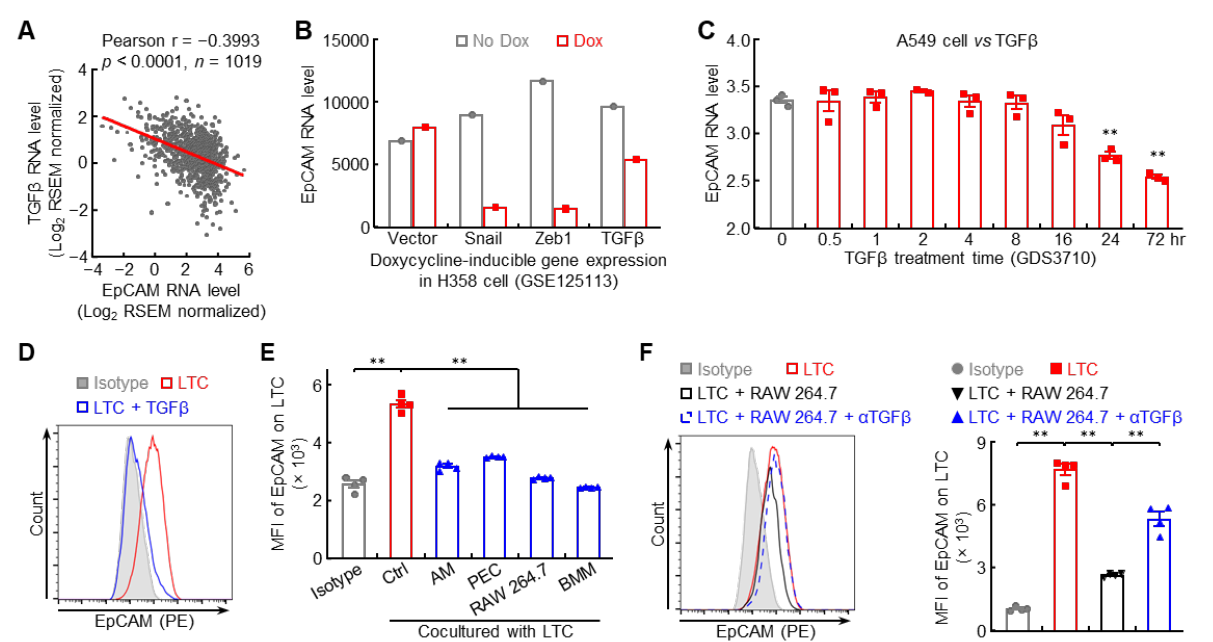
Figure 7. Macrophage-derived TGFβ represses EpCAM expression in lung cancer cells. ( A ) TCGA LUNG data showing negative association between EpCAM and TGFβ. ( B ) GSE125113 data showing decreased EpCAM expression in H358 cell overexpressing TGFβ. ( C ) GDS3710 data showing EpCAM downregulation by TGFβ in A549 cell ( n = 3). ( D ) FACS data showing decreased EpCAM protein expression by TGFβ in murine lung tumor cell ( n = 4). LTC: lung tumor cell which was established from spontaneous FVB/N lung tumor. ( E ) FACS data showing repressed EpCAM expression in murine lung tumor cells by macrophage coculture ( n = 4). AM: alveolar macrophage, PEC: peritoneal macrophage, BMM: bone marrow derived macrophage. ( F ) FACS data showing lung tumor cell EpCAM downregulation by RAW 264.7 coculture was restored by TGFβ neutralizing antibody ( n = 4). Data are representative of three independent experiments with similar results ( D – F ). Student’s t test (two-tailed, unpaired) was performed. Data represent means ± SEM ( C , E , F ). ** p < 0.01.